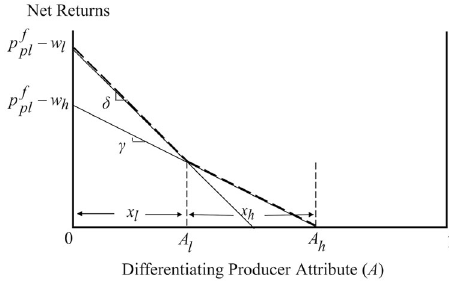
Fig. 3 Producer decisions in Scenario II. This fi gure graphs the producer net returns for Scenario II. In this scenario, the low-quality and high-quality products coexist in the market, with the high-quality product produced by less ef fi cient producers.